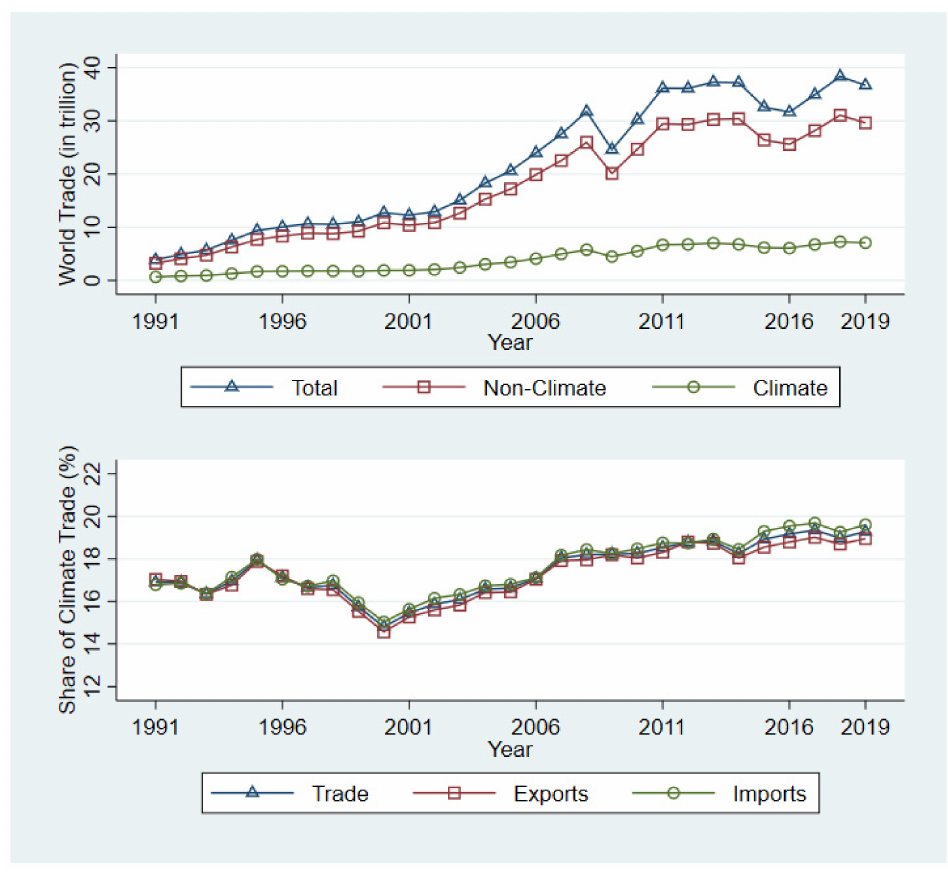
Figure 1. Trends of International Climate, non-climate, and Total Trade. Note: Authors’ calculation by using the UN Comtrade data. Source: UN Comtrade. International Trade Statistics-Import/Export Data (accessed on 8 May 2021)